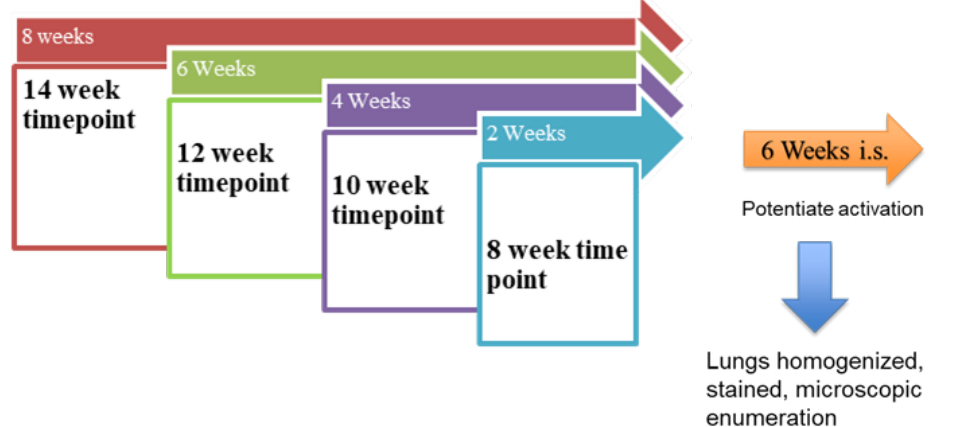
Scheme 1. Prophylaxis Model. The arrows above the boxes represent the length of drug